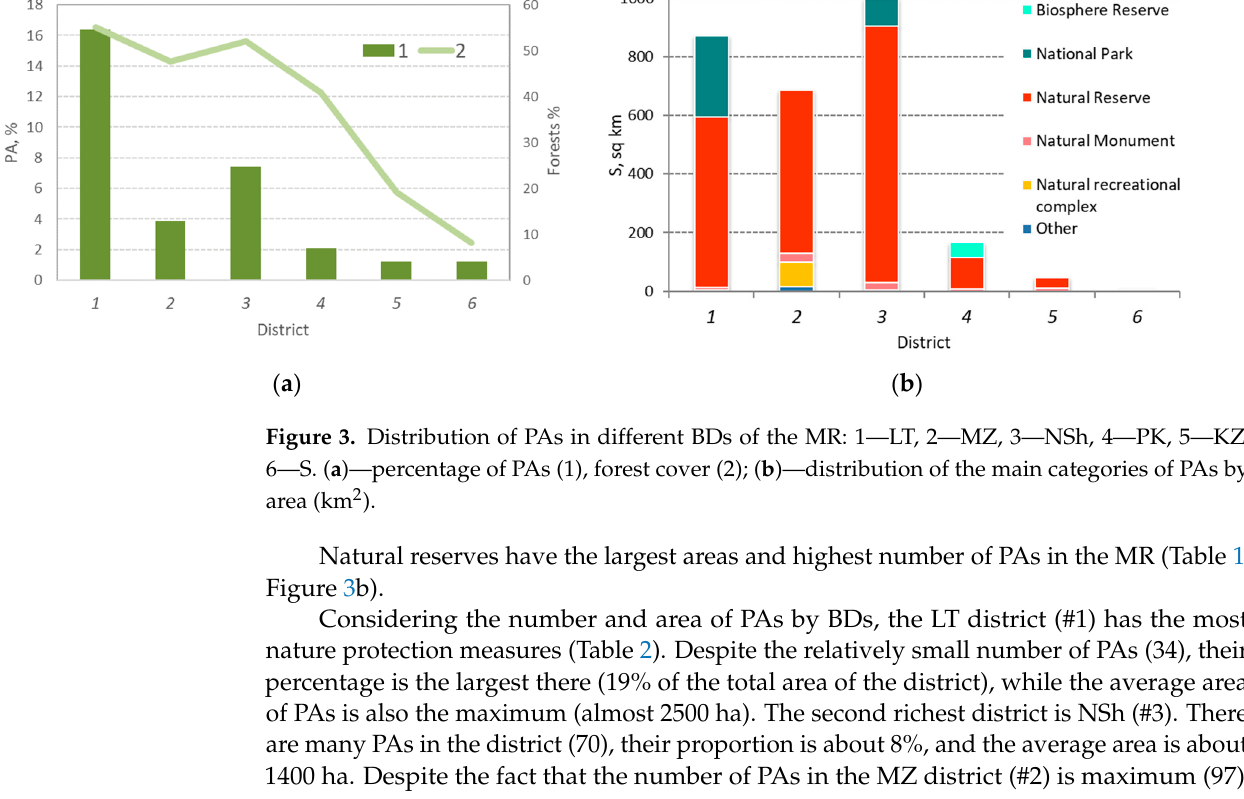
Table 2. Average area and number of PAs in BDs.